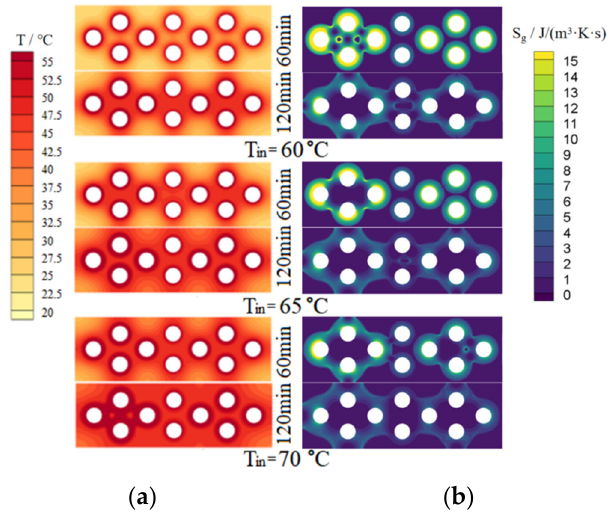
Figure 8. Simulated temperature and entropy generation rate fields of PCM-1 upper surface. ( a ) Temperature fields; ( b ) Entropy generation rate fields.